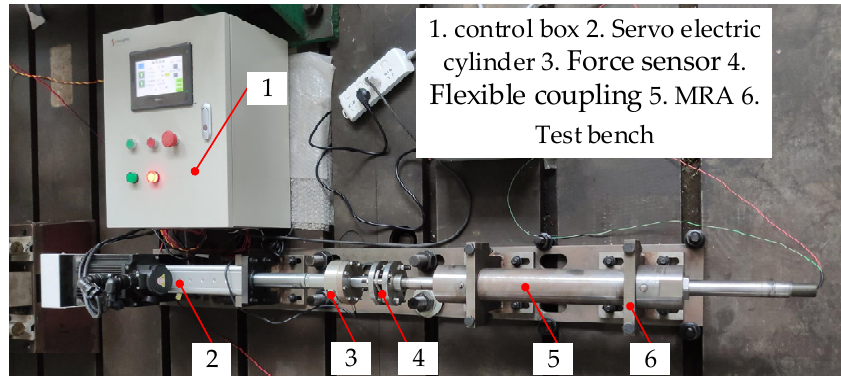
Figure 9. Servo electric cylinder test bench.